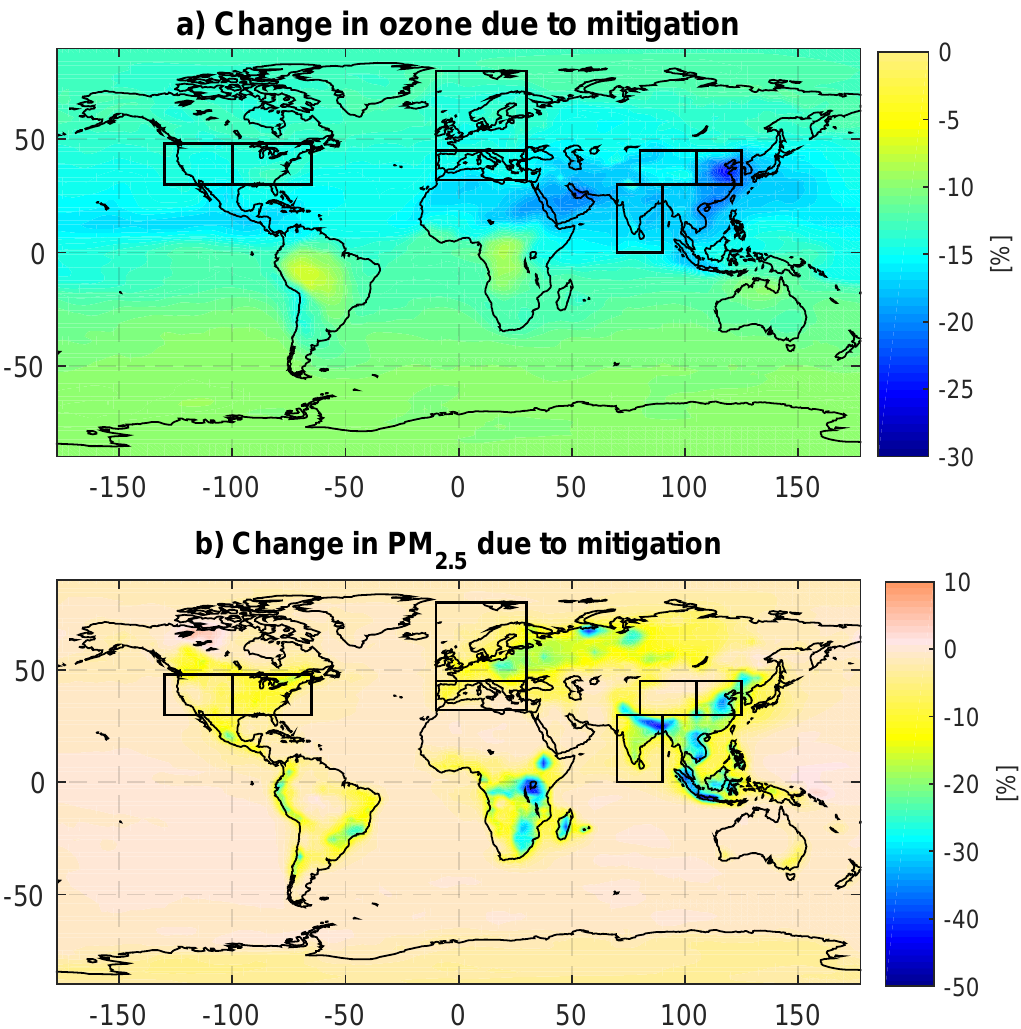
Figure 10. Relative difference maps (in %) for the surface concentrations of O 3 and PM 2 . 5 , as obtained from simulations based on the emis- sion mitigation (MIT) scenario and the current legislation (CLE) scenario, i.e. (100 × (MIT − CLE) / CLE). Shown are mean concentration differences for the period 2041–2050 and averaged over model results from OsloCTM2, NorESM and HadGEM. The black boxes define the regions used in Table